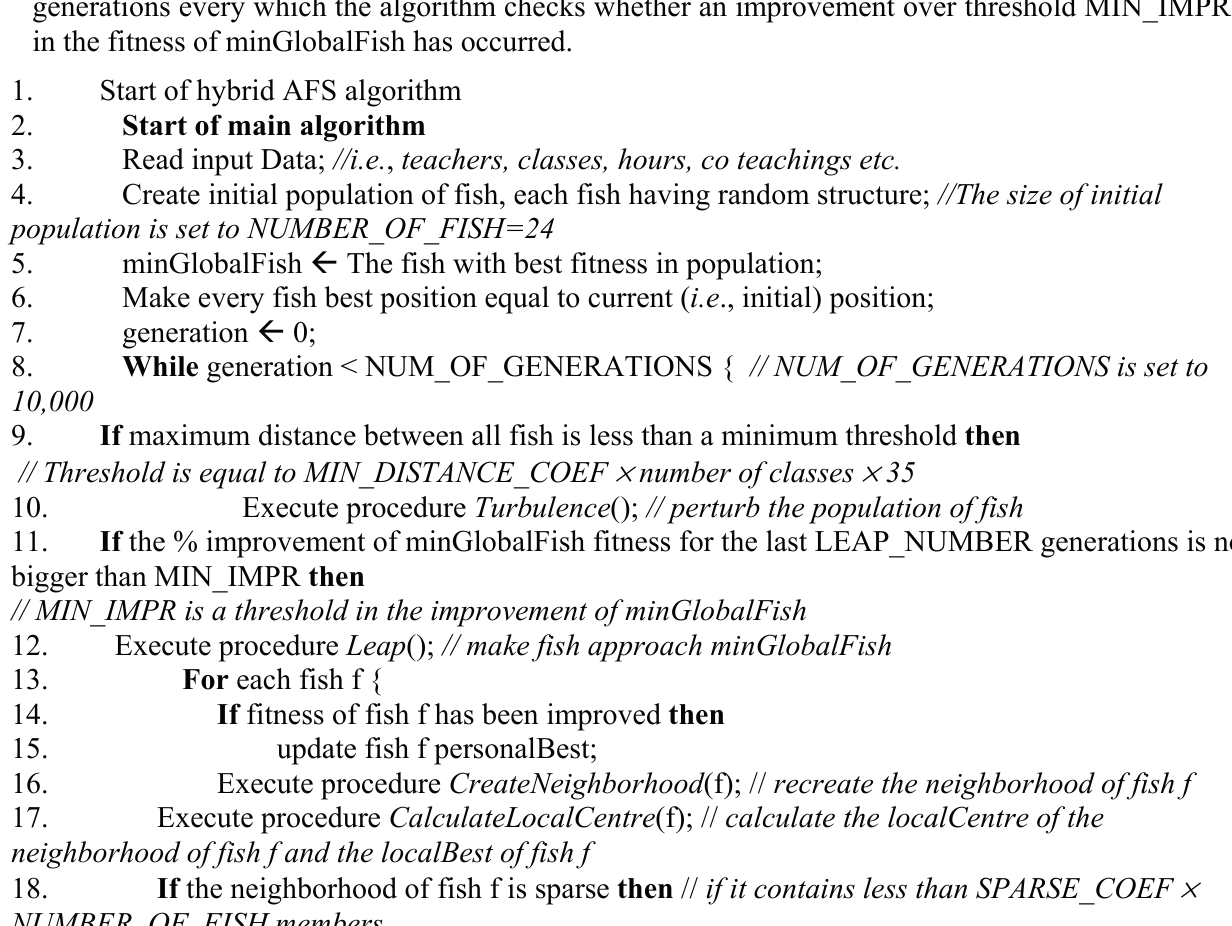
Algorithm 2: The pseudo code of the main AFS